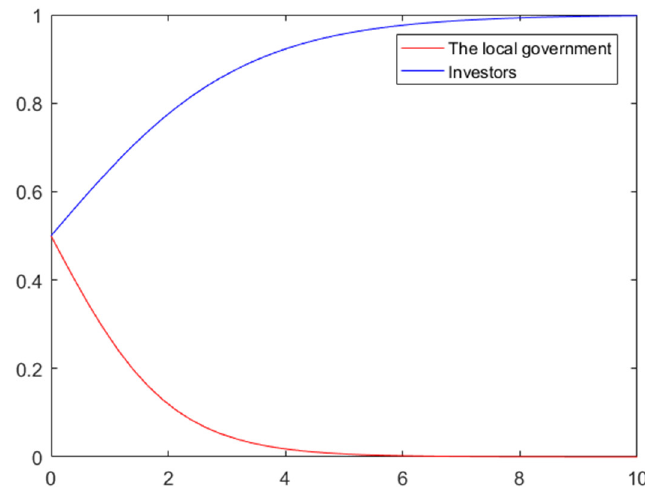
Figure 3. Simulation results in the bubble germination stage.